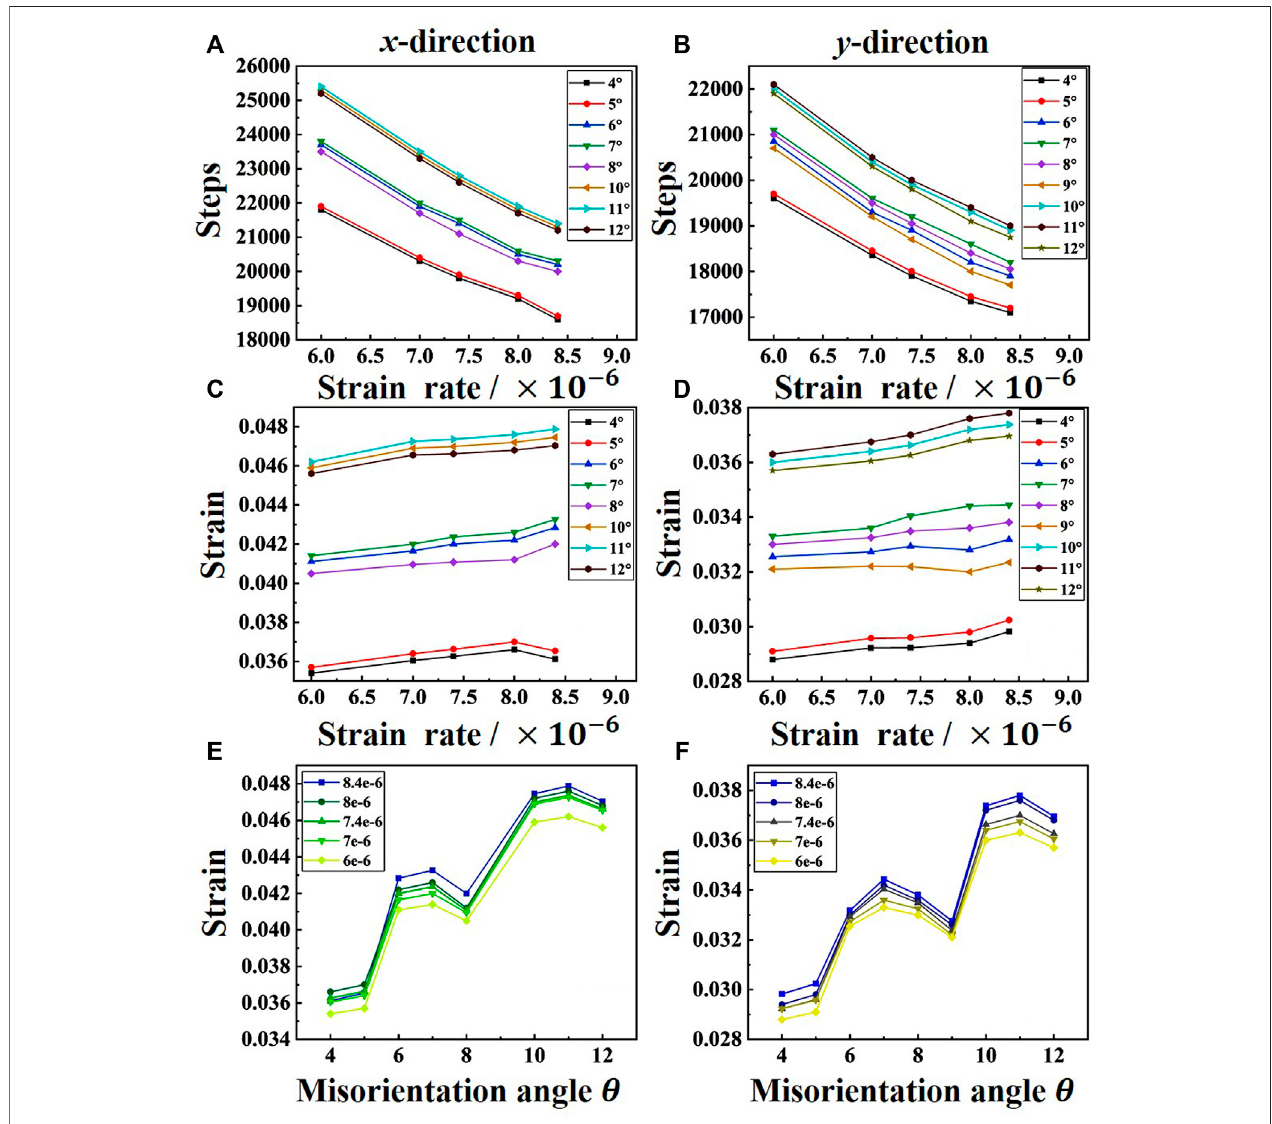
FIGURE 9 | Critical strain distribution of dislocations decomposition under different strain rates and GBMs conditions. (A) , (C) , (E) The critical strain distribution of tensile deformation in the x -direction; (B) (D) , (F) the critical strain distribution of tensile deformation in the y -direction.